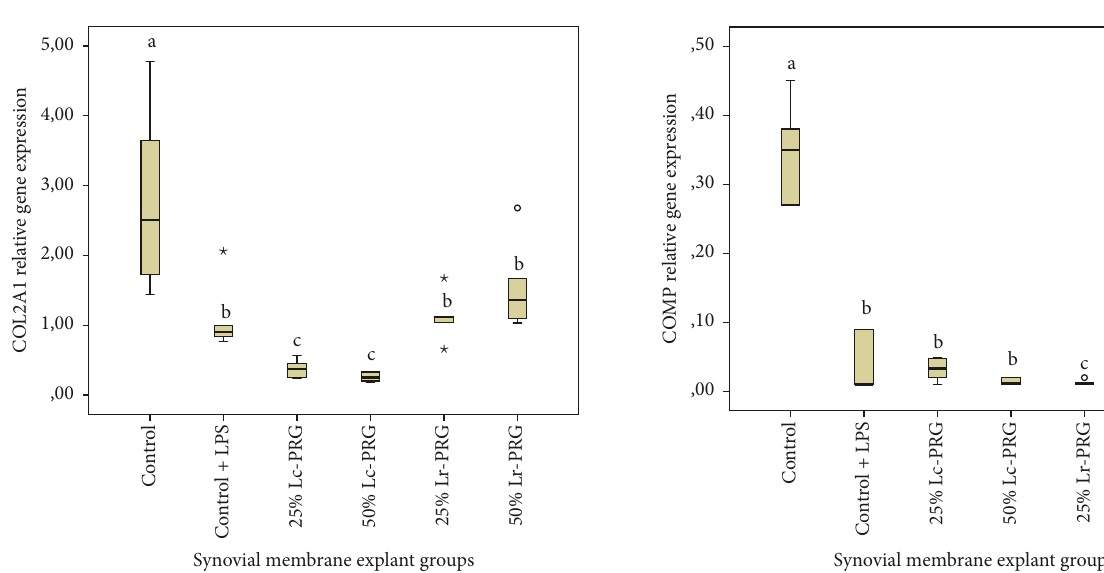
Figure 7: Box plot of median relative cartilage oligomeric matrix protein (COMP) gene expression. a–c Lowercase letters denote sig- nificant differences (𝑝 > 0.05) between SME groups treated with Lc-PRG and Lr-PR supernatants at different concentrations (25 and 50%). Groups with the same lowercase letter are not significantly different. ∘ denotes an outlier value, showing nonparametric